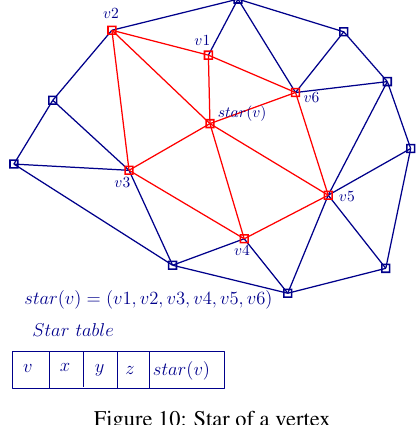
Figure 10: Star of a vertex